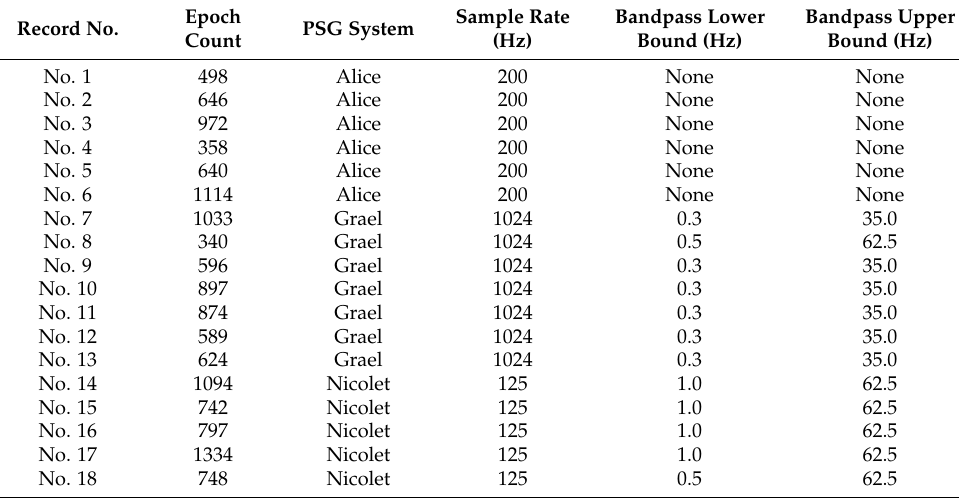
Table 1. Data collection conditions for the Clinical dataset. Record No.